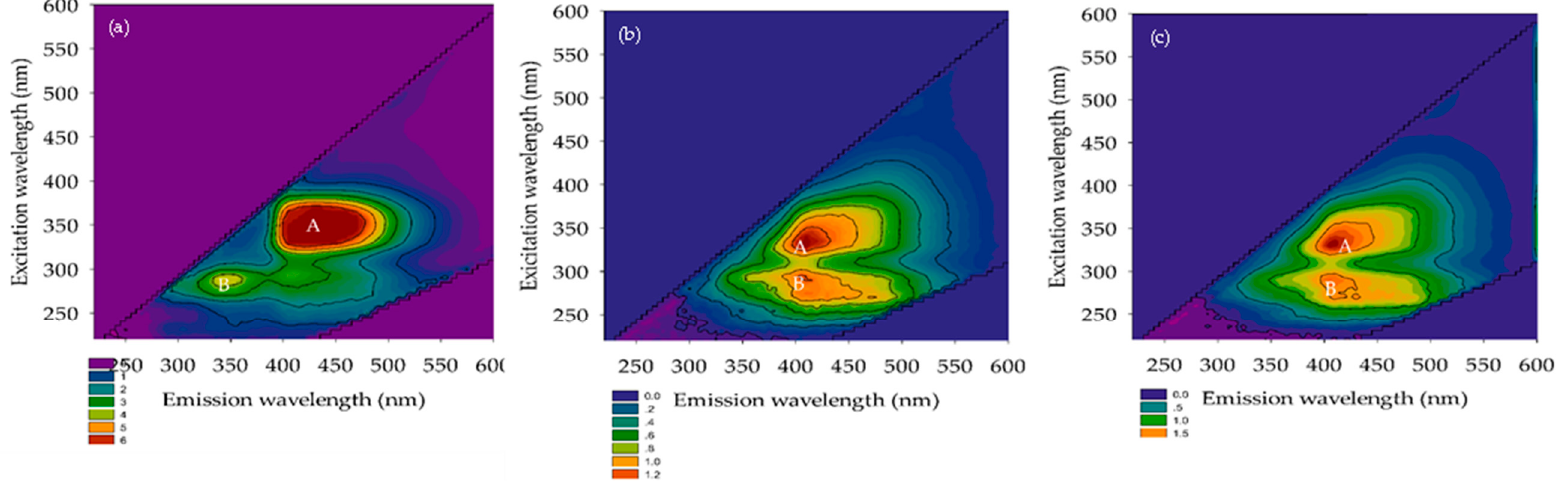
Figure 10. FEEM of the A/O-MBR and O-MBR systems at a SRT of infinity. ( a ) Raw wastewater. ( b ) Permeate from A/O-MBR (System 1). ( c ) Permeate from O-MBR (System 2).